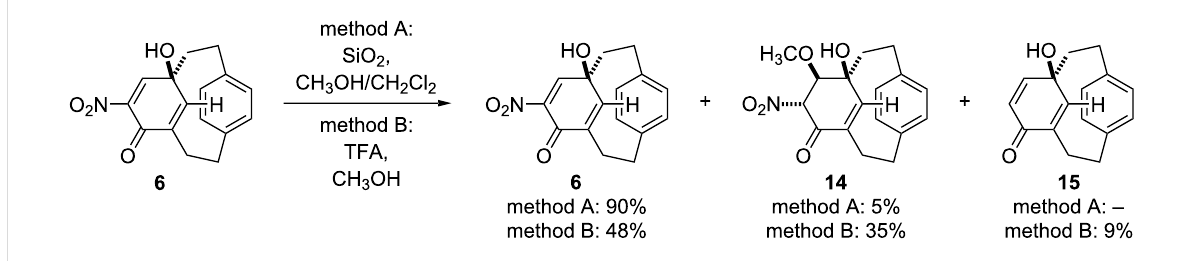
Scheme 3: Conjugate addition of methanol and subsequent elimination.